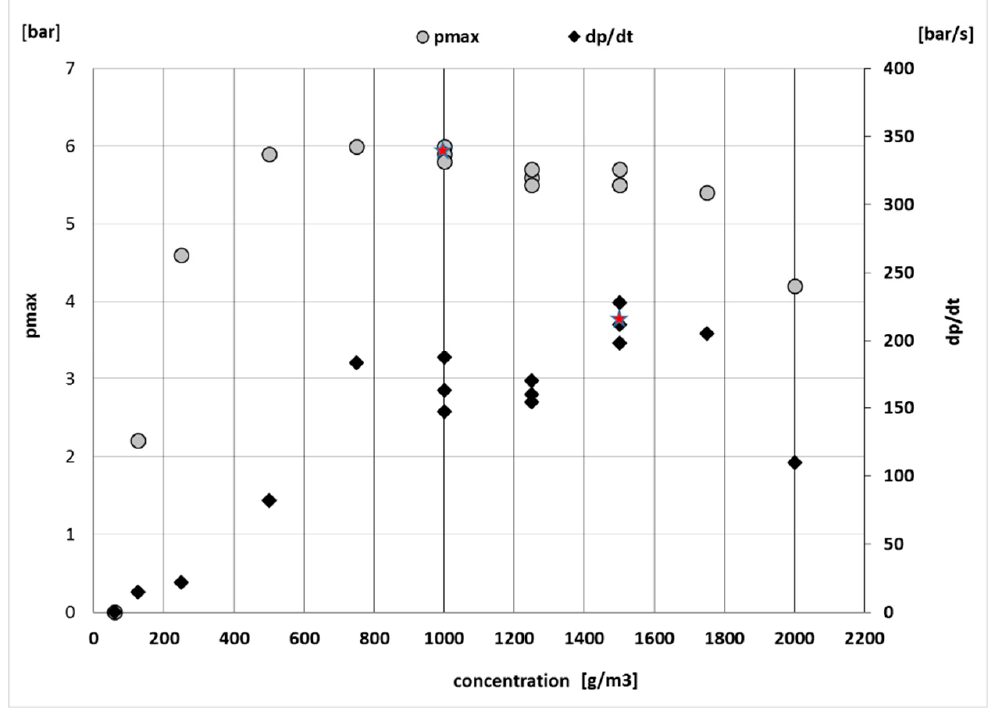
Figure 5. Influence p max on concentration of industrial dust.